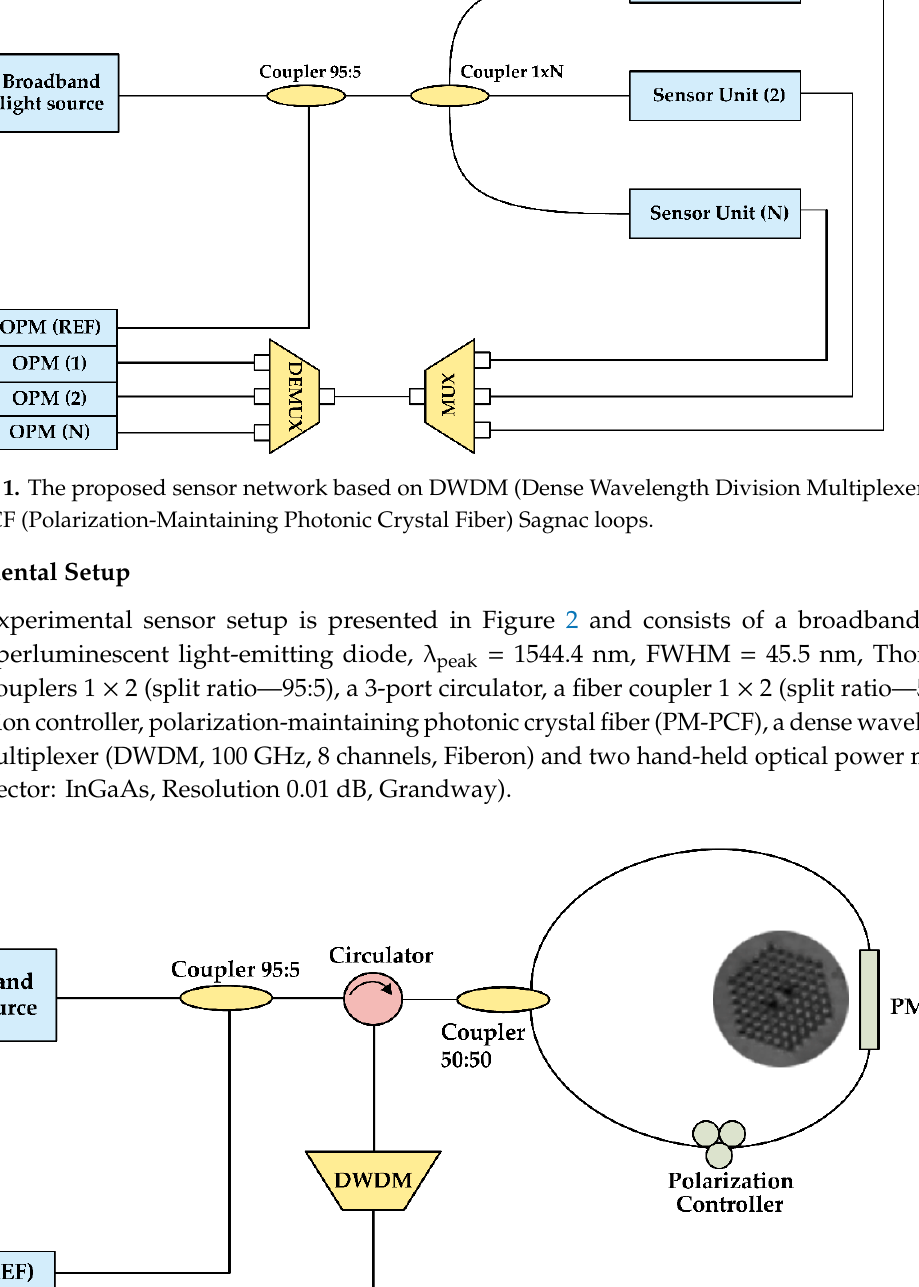
Figure 1. The proposed sensor network based on DWDM (Dense Wavelength Division Multiplexer) PM-PCF (Polarization-Maintaining Photonic Crystal Fiber) Sagnac loops.